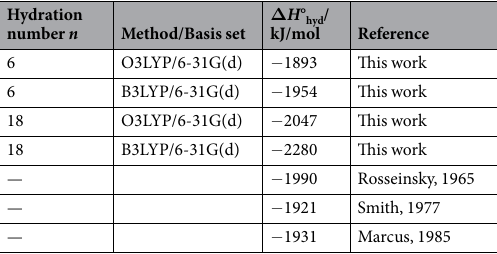
Table 1. Hydration enthalpy of Mg(H 2 O) n 2 +